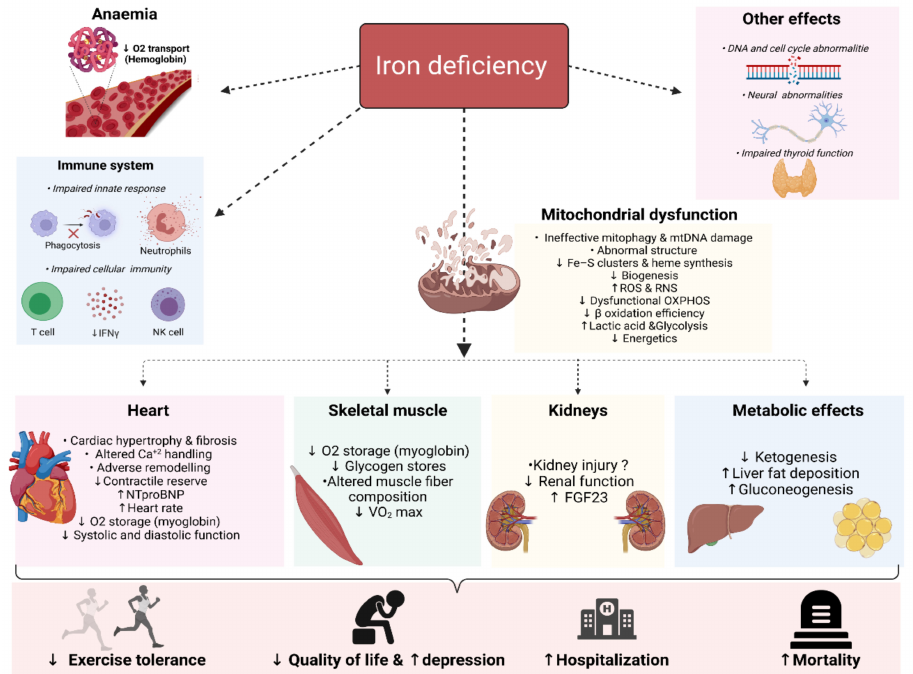
Figure 3. Overview of the biological consequences of iron deficiency. NTproBNP: N-terminal pro- b-type natriuretic peptide; OXPHOS: Oxidative phosphorylation; RNS: reactive nitrogen species; ROS: reactive oxygen species and FGF23: Fibroblast growth factor-23 (Created with BioRender.com, accessed on 24 November